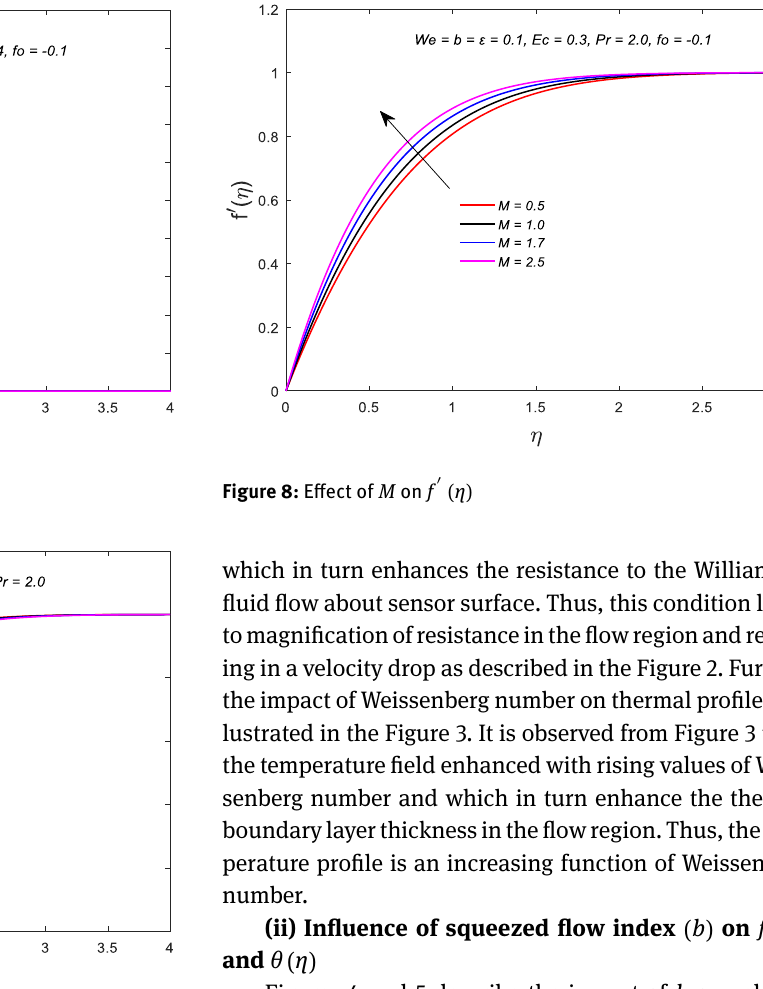
Figure 6: Effect of f o on f (cid:48) ( η )